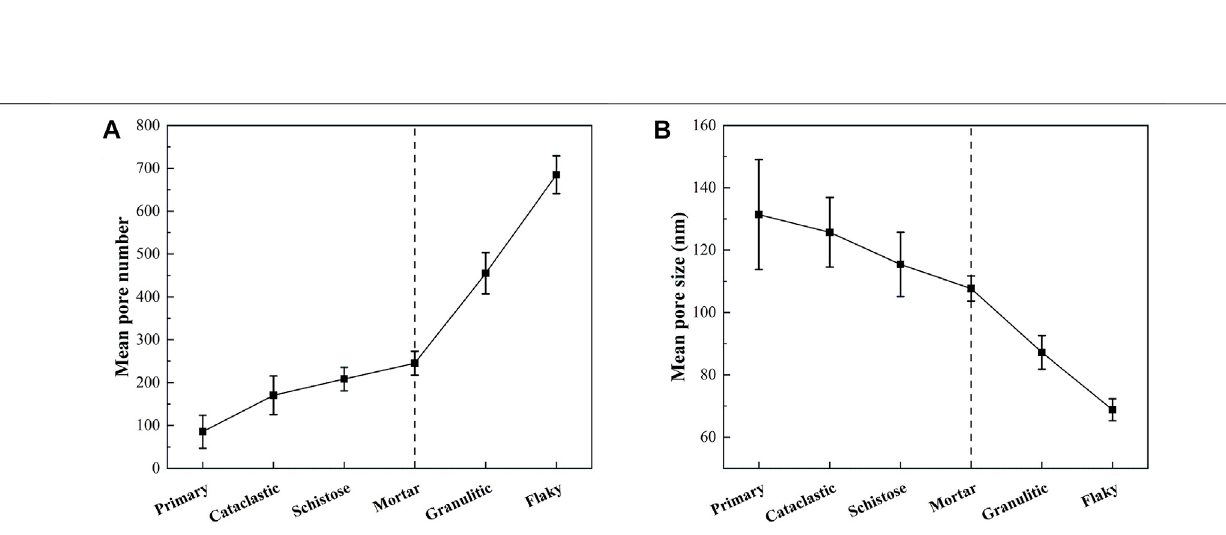
Frontiers in Earth Science |